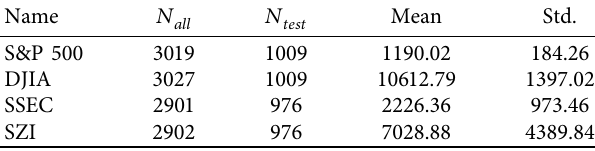
Table 1: The data and their descriptive statistical analysis.